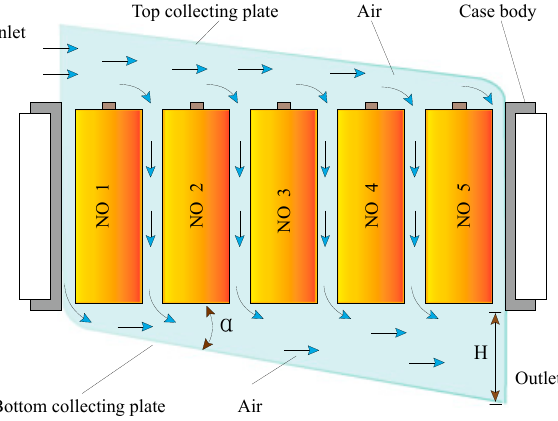
Figure 4. Structural diagram of air cooling system.